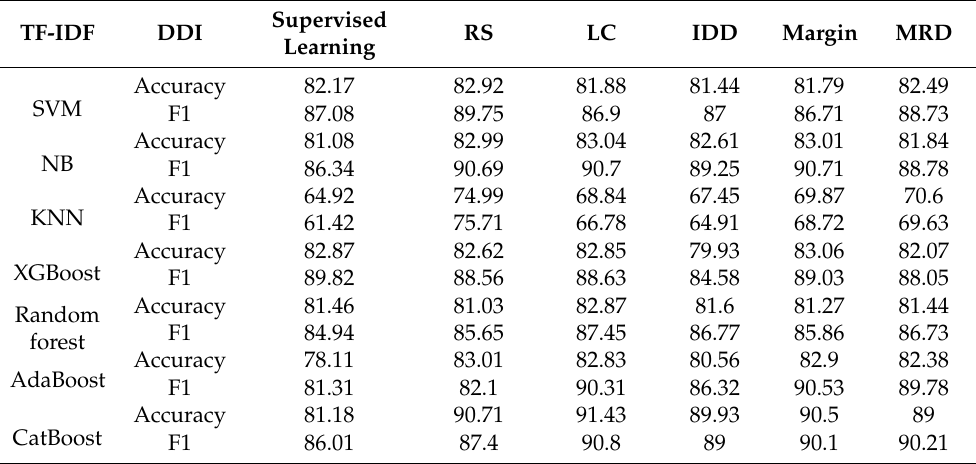
Table 2. Comparison of results with and without AL methods (TF-IDF) for DDI dataset. TF-IDF DDI